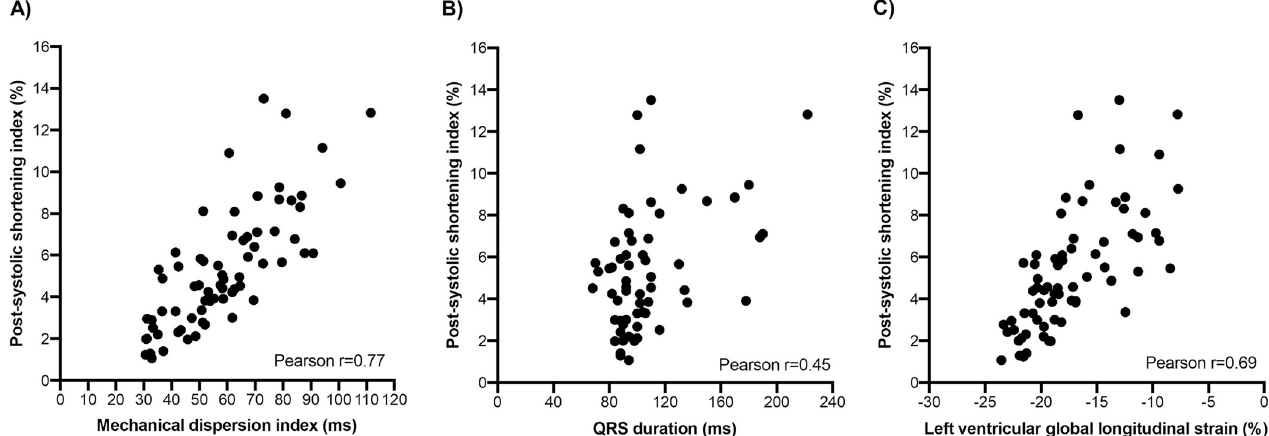
Fig 5. Correlation scatterplots between post-systolic shortening index and (a) mechanical dispersion index, (b) QRS duration and (c) left ventricular global longitudinal strain.